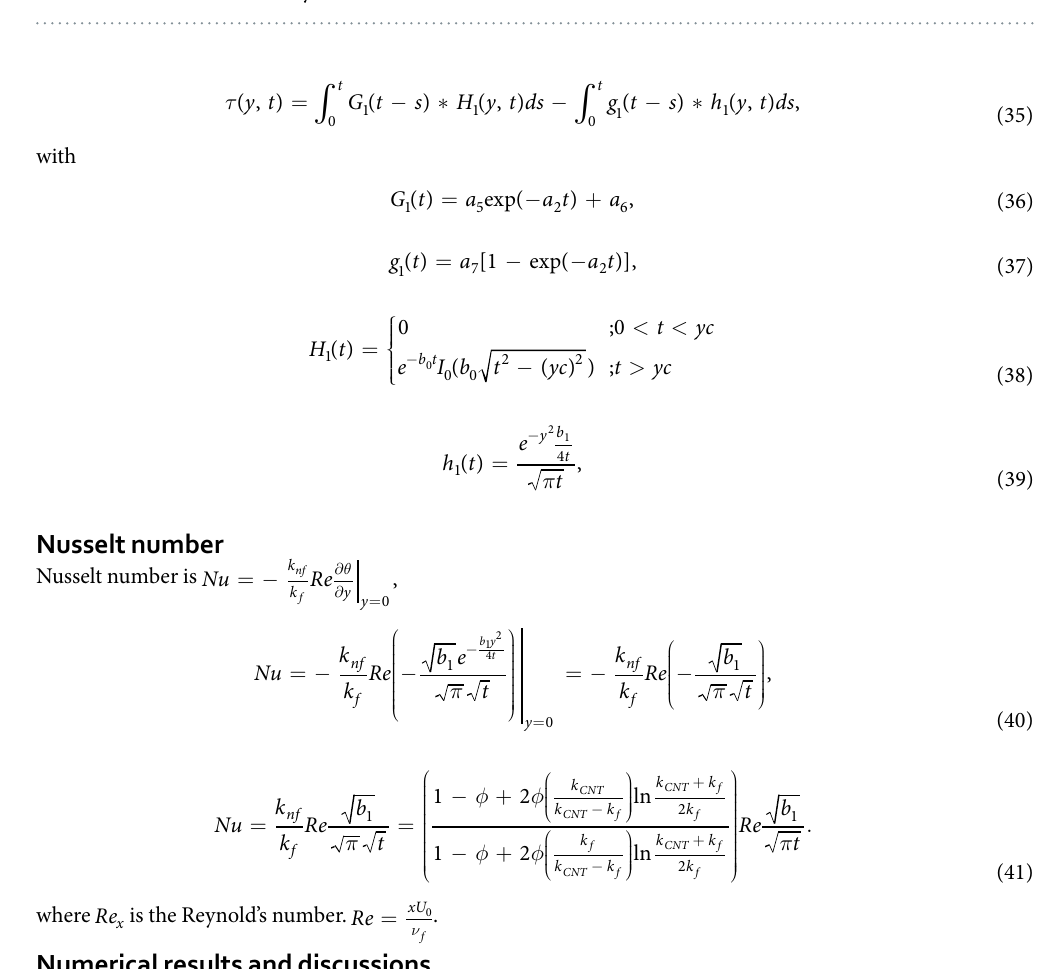
Table 2. Thermal conductivity values of CNTs for different values of volume